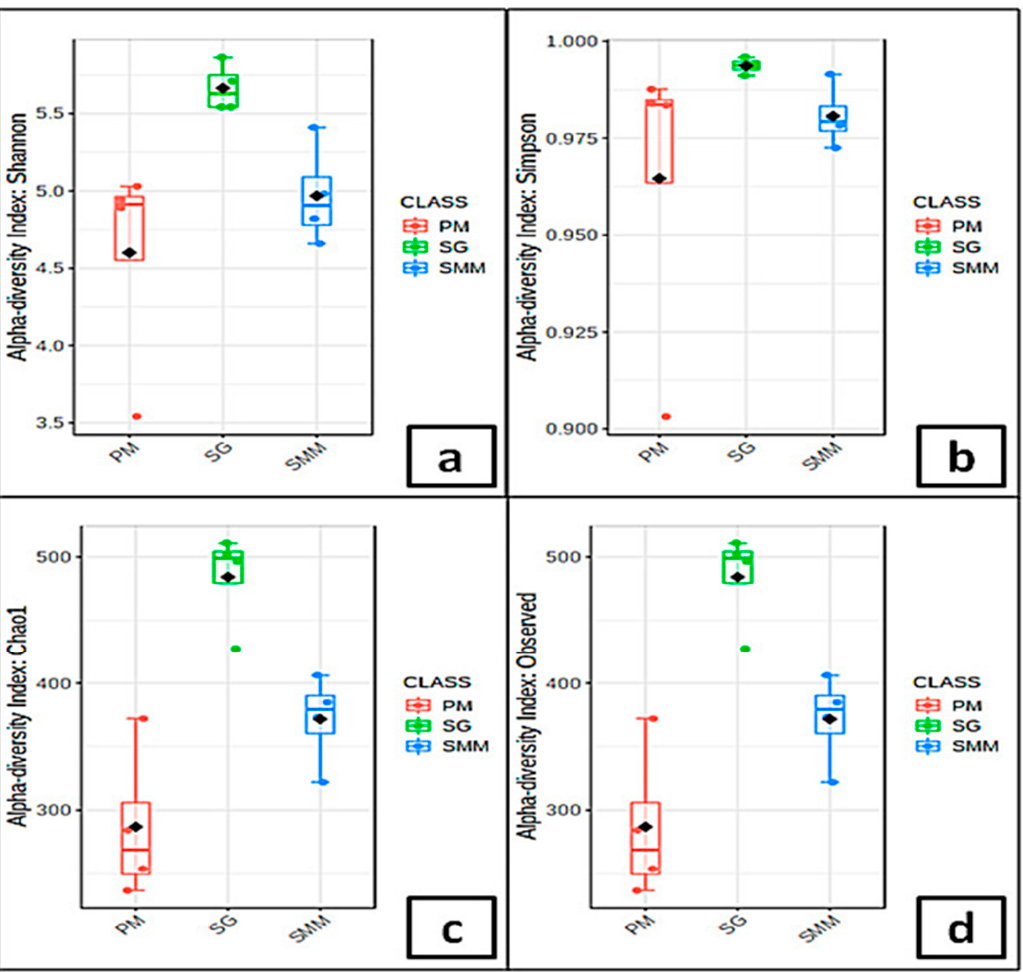
Figure 4. Box-plots of the bacterial α -diversity using: ( a ): Shannon Diversity Index, ( b ): Simpson’s Index, ( c ): Chao1 Diversity Index, and ( d ): observed ASVs of SAMCs among sampling periods. SMM: